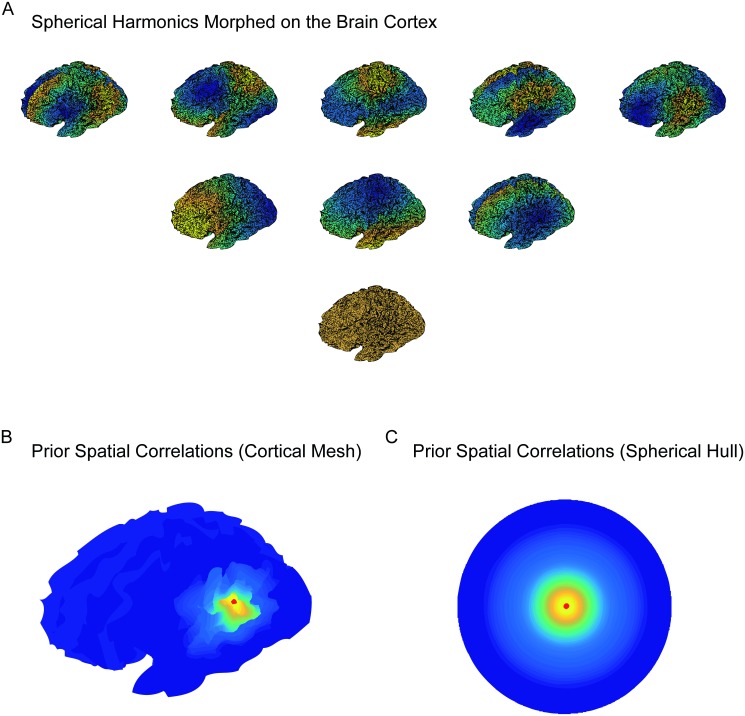
Spherical harmonics and covariance functions.Visualization of the spherical harmonics morphed onto the cortex and the resulting spatial correlation structure. A) Example of spherical harmonics on the brain cortex for frequency numbers from 0 to 2. For each frequency number l there are 2l+1 harmonics with “phase” number m ranging from −l to l. As clear from the picture, the spatial frequency increases as a function of the frequency number. In all our analyses we truncated the harmonic expansion after the 11th frequency number. B,C) Prior correlation structure induced by Eq (24). Panel B shows the prior correlations on the cortical surface from a cortical point identified by a red dot. Panel C shows the same function on the spherical hull. The spatial correlations are determined by the frequency discount function f(l); here we used the same smoothing parameters as all analyses in the paper: k = 2 and υ = 3.